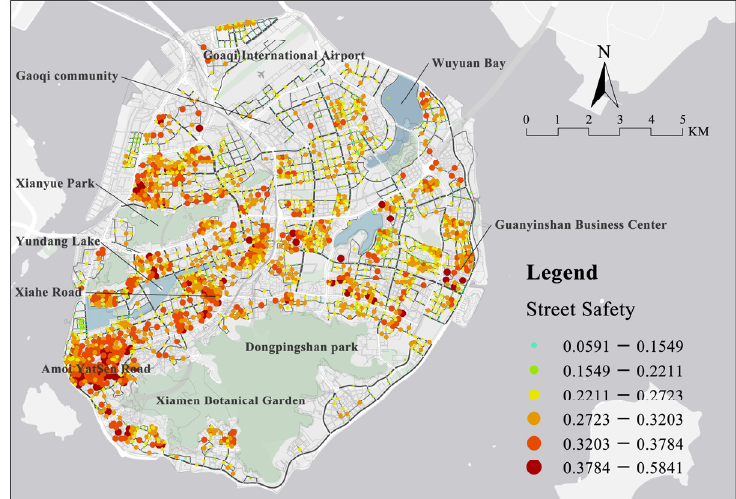
Figure 8. Spatial distribution of street safety on Xiamen Island.